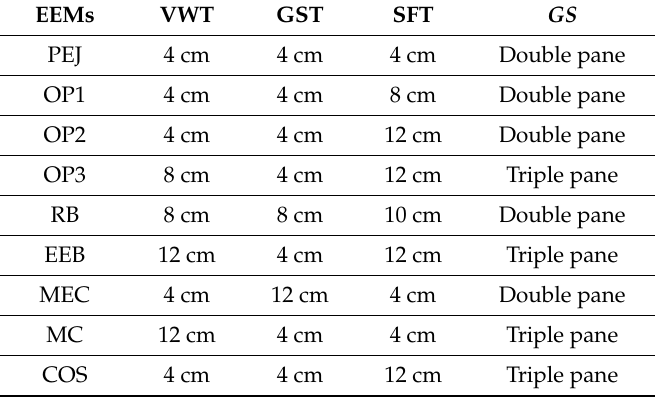
Table 10. Detected optimal constructive solutions concerning di ff erent energy e ffi ciency measures (EEMs) for climatic zone B (VWT, insulation thickness in vertical wall; GST, insulation thickness in the ground slab; SFT, insulation thickness in the second last floor; GS, glazing